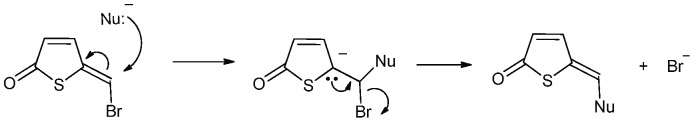
Proposed reaction mechanism of the thiophenones.Nu: nucleophile. Candidate nucleophiles are e.g. thiol groups of cysteine residues.